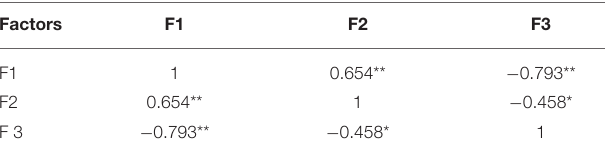
TABLE 10 | Factor correlation matrix for the structure factor solution. Factors